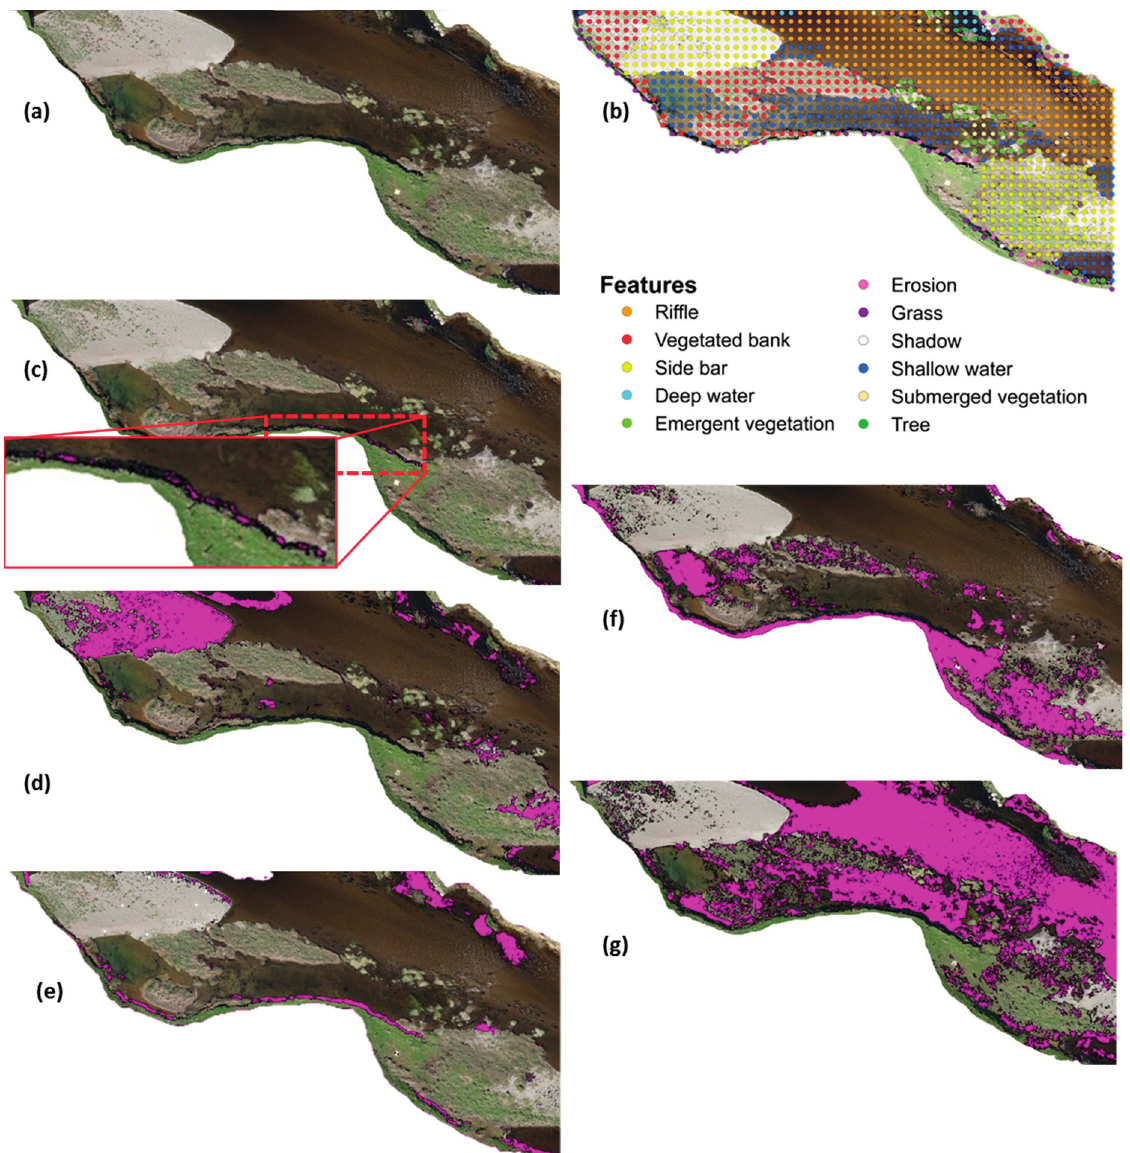
Figure 5. Example of Artificial Neural Network (ANN) classification outputs obtained with the Leaf Area Index Calculation (LAIC) for a selected portion of the orthoimage. Pixels elected within each class are shown in pink. ( a ) Original image; ( b ) Visual classification for the points defined by a 2 m × 2 m regular grid; ( c ) Erosion; ( d ) Side bars; ( e ) Deep water; ( f ) Vegetation (all classes); ( g ) Riffles. The image is not to scale. Shallow waters presented the same errors as those already described beforehand. Here, shallow water with rippled water surface was automatically classified as riffles. This could not be identified as an error in classification but as higher resolution in feature detection than expected. When correcting for this effect, the TPR increased to 69% for shallow water, with a rate of TN equal to 81%. Misclassification of shallow waters as shadows primarily occurred in areas below trees or water areas obscured by brown submerged vegetation. In the first instance, we assumed that the visual classification was inaccurate whereas in the second case vegetation generated dark undistinguishable and even shadow